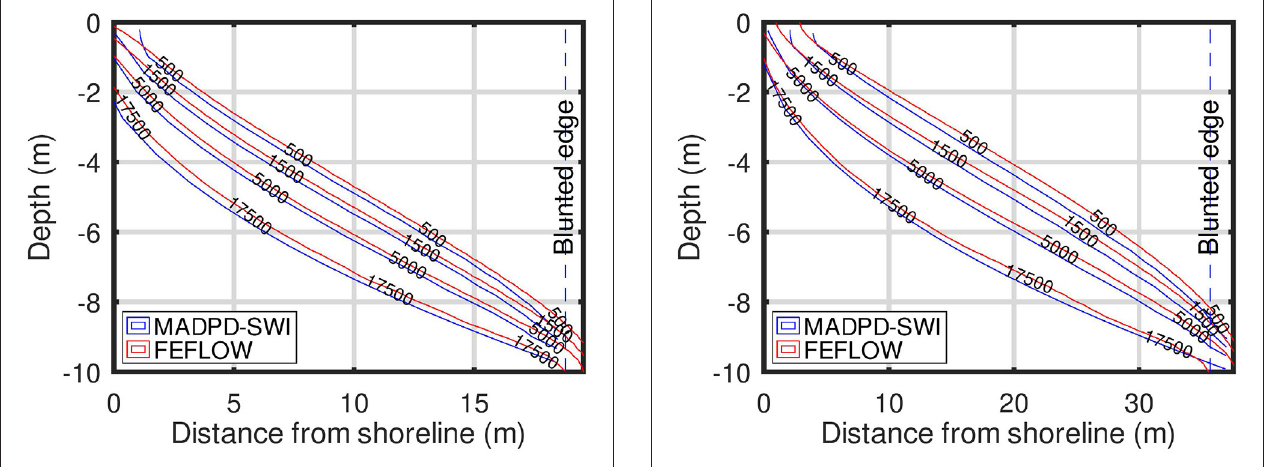
FIGURE 2 | Lines of constant salinity [ppm TDS] of the FEFLOW and 2D-MADPD-SWI solutions for α = 5.